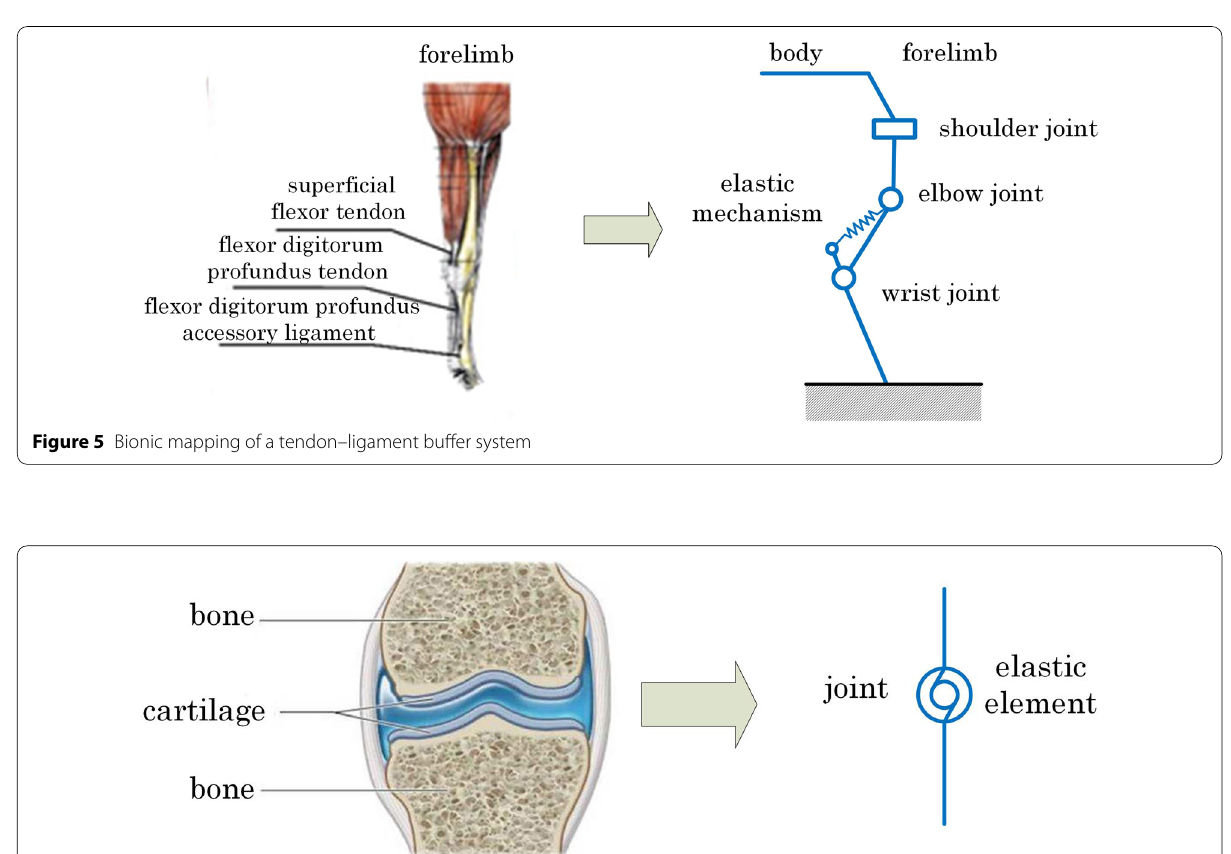
Figure 6 Bionic mapping of joint